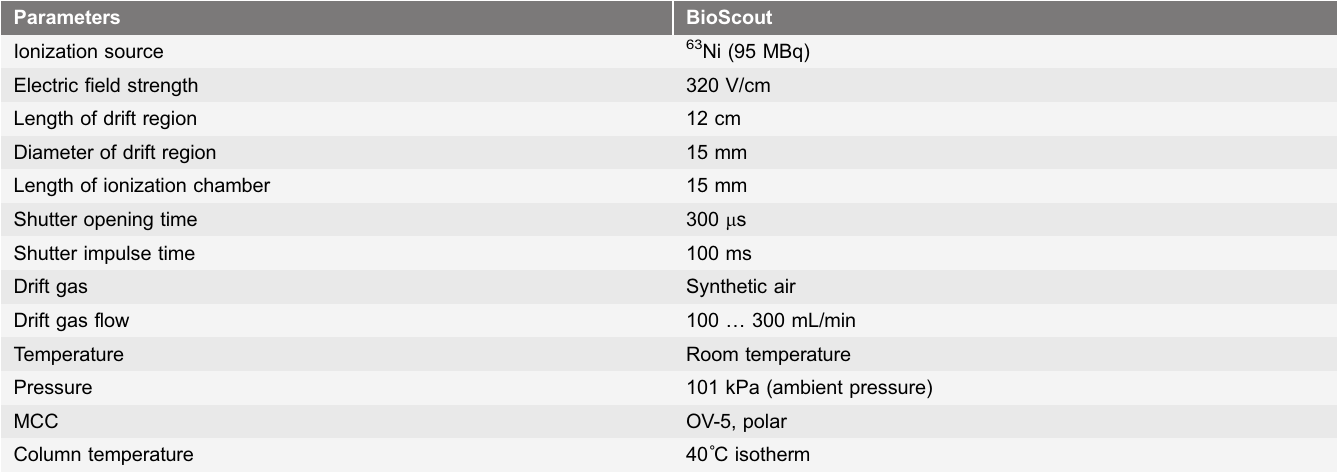
Table 1. Characteristics of ion mobility spectrometer